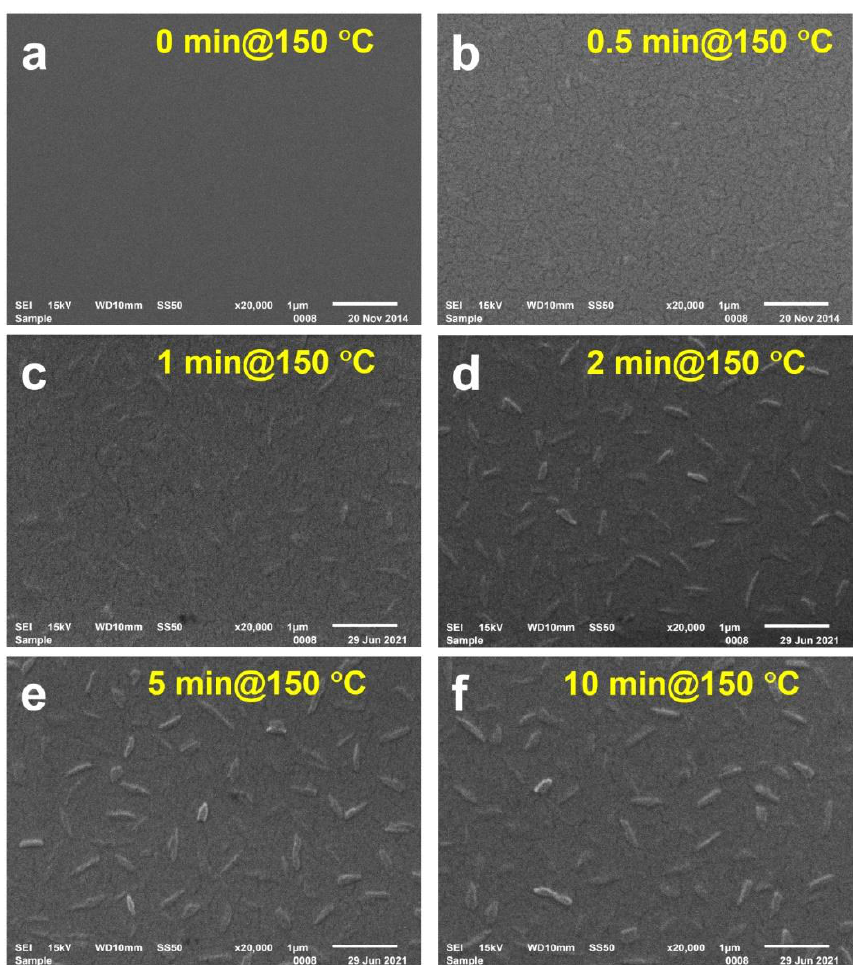
Figure 4. SEM images at an annealing temperature of 150 °C for ( a ) 0, ( b ), 0.5, ( c ) 1, ( d ) 2, ( e ) 5, and ( f ) 10 min.